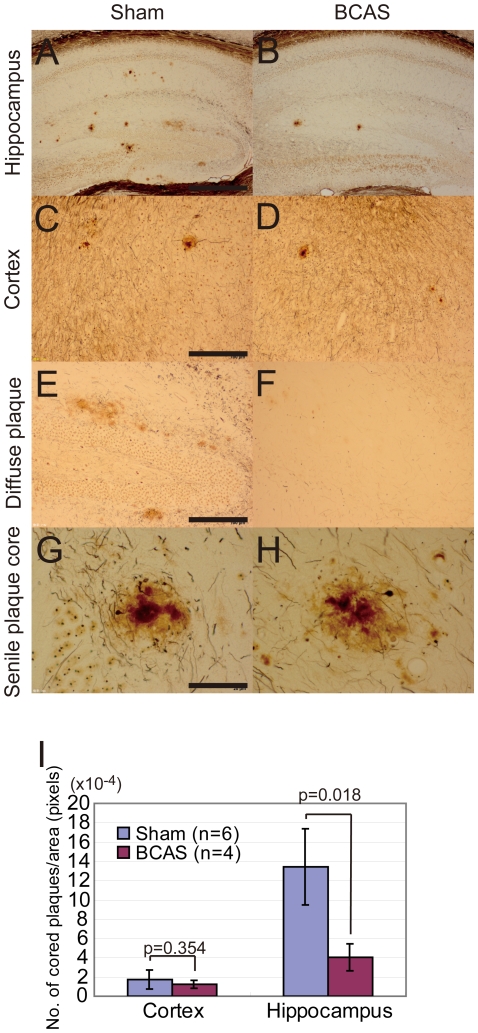
Chronic cerebral hypoperfusion affected the number of silver-stained cored plaques in the APPSw/Ind-Tg mice.Modified Bielschowsky staining showed cored plaques in the hippocampus (A, B, G, H) and the cerebral cortex (C, D), and diffuse plaques in the hippocampus (E, F) of the APPSw/Ind-Tg/sham mice (n = 6; A, C, E, G) and APPSw/Ind-Tg/BCAS mice (n = 4; B, D, F, H). Number of cored plaques was counted in the cortex and the hippocampus (I). Scale bars: 400 µm (A, B), 300 µm (C-F), 80 µm (G, H).